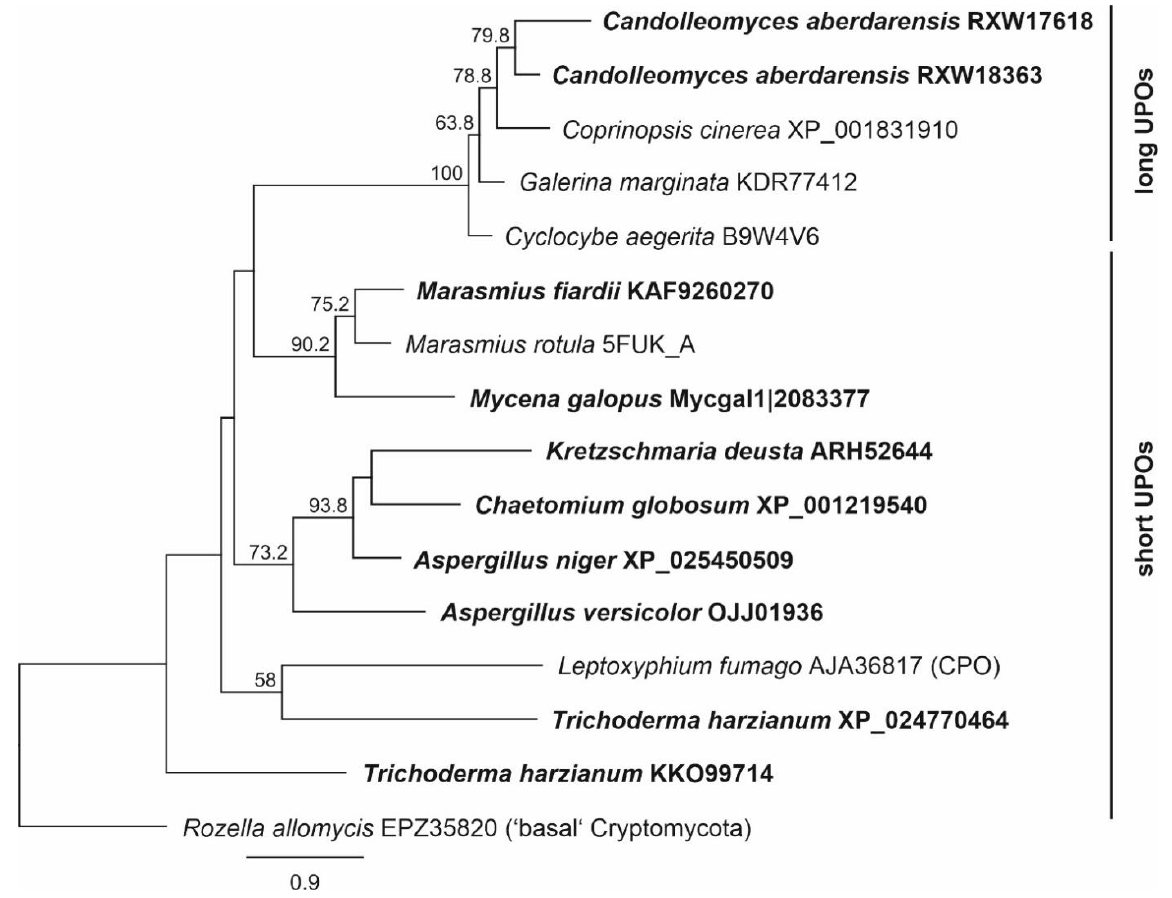
Figure 1. Maximum likelihood tree including unspecific peroxygenase (UPO) candidates for recom- binant expression and references. Branch support was estimated by 500 bootstrap replicates.